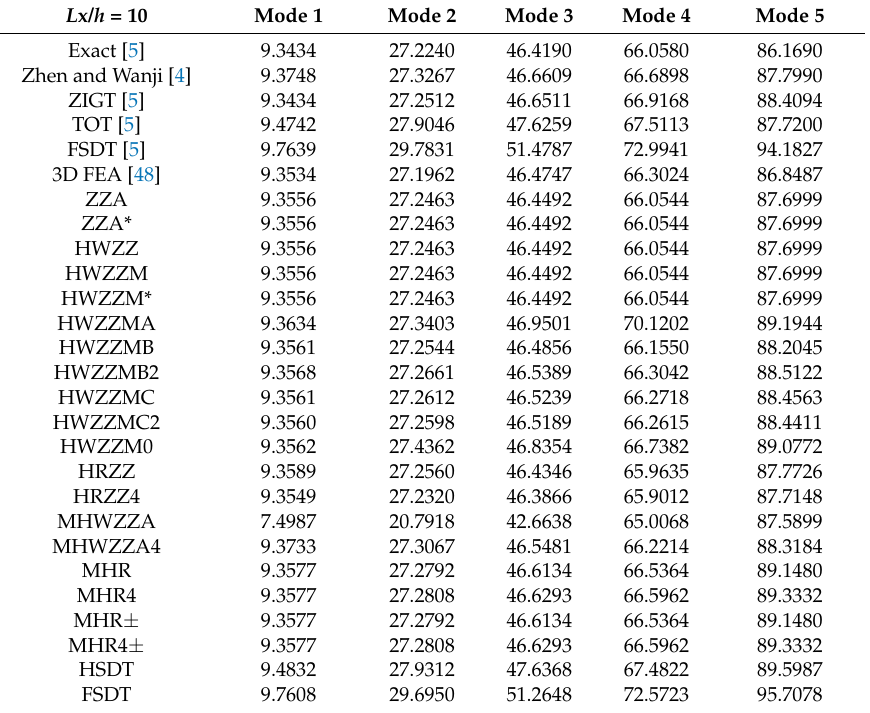
Table 13. Normalized fundamental frequencies, case e1.